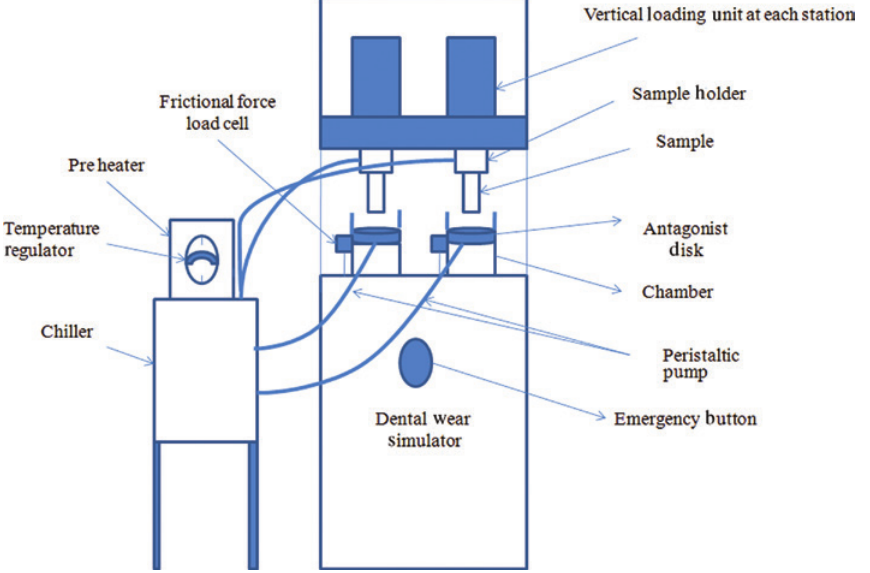
Figure 1: Schematic diagram of dental wear test rig.